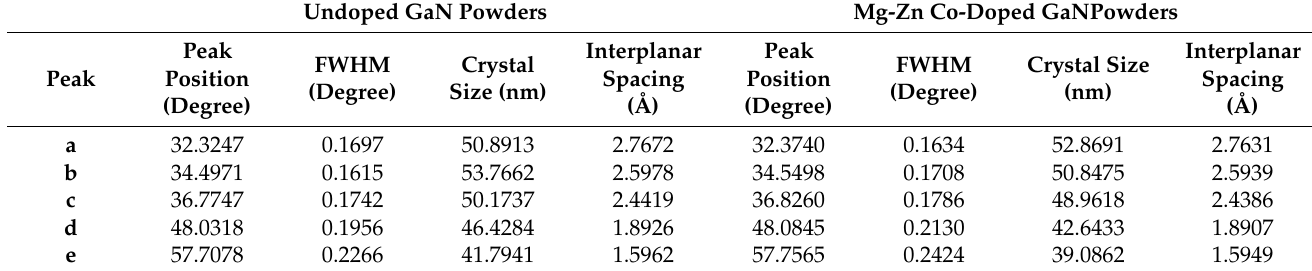
Table 2. Values calculated for peak position, FWHM, crystal size, and interplanar spacing for undoped GaN and Mg-Zn co-dopedGaN